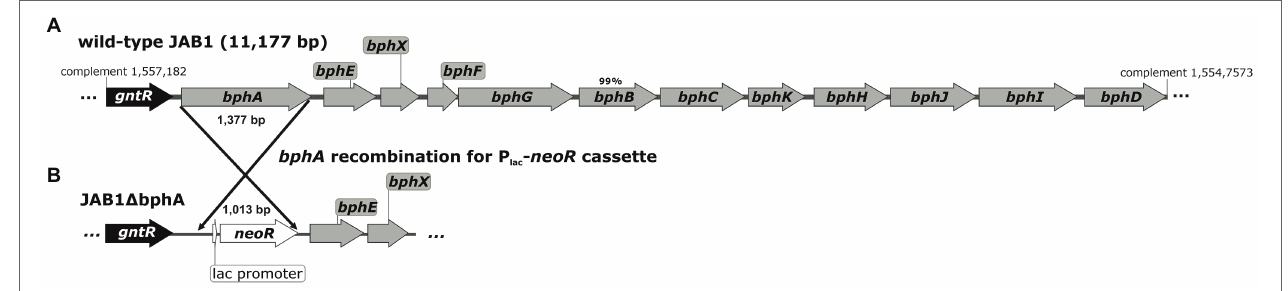
FIGURE 1 | Architecture of the biphenyl/PCB degradation pathway ( bph operon) in the wild-type JAB1 (A) and in the bphA -null mutant JAB1 Δ bphA (B) . The position of the bph operon in the JAB1 annotated whole genome sequence (Genbank accession no. CP016162.1) is indicated. The deduced protein sequences encoded by all genes shown were 100% identical with their homologues from Pseudomonas furukawaii KF707, except BphB with the identity score of 99%. The gene gntR encodes for a putative GntR-family transcription regulator; bphA and bphE – large and small subunit of the two-component biphenyl dioxygenase, respectively; bphX – protein with unknown function; bphF and bphG – ferredoxin and ferredoxin reductase, respectively; bphB – cis -2,3- dihydrobiphenyl-2,3-diol dehydrogenase; bphC – 2,3-dihydroxybiphenyl-1,2-dioxygenase; bphK – glutathione S-transferase; bphH –